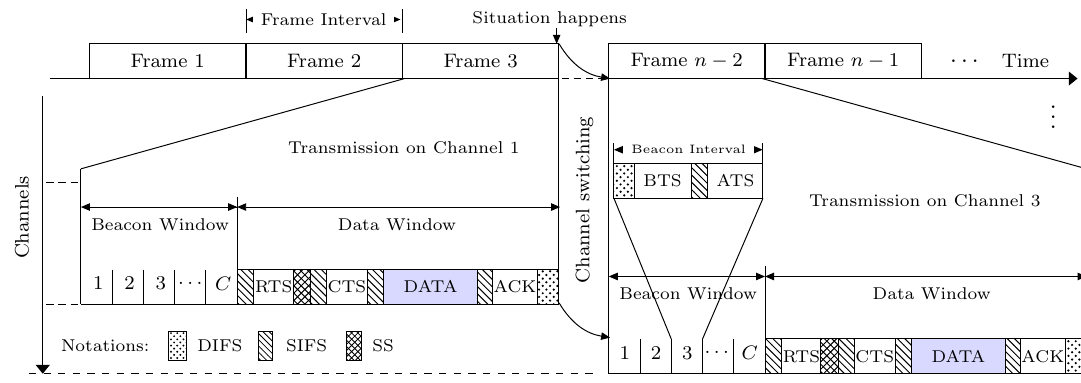
Figure 3. RSMA/CA access mechanism in time channel domain. BTS, Beacon to Sense; ATS, Acknowledge to Sense; RTS, Request to Sense; CTS, Clear to Sense; SS, Spectrum